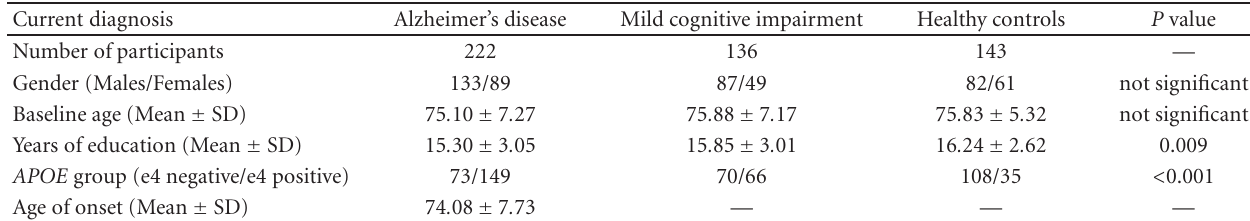
Table 1: Sample demographics.